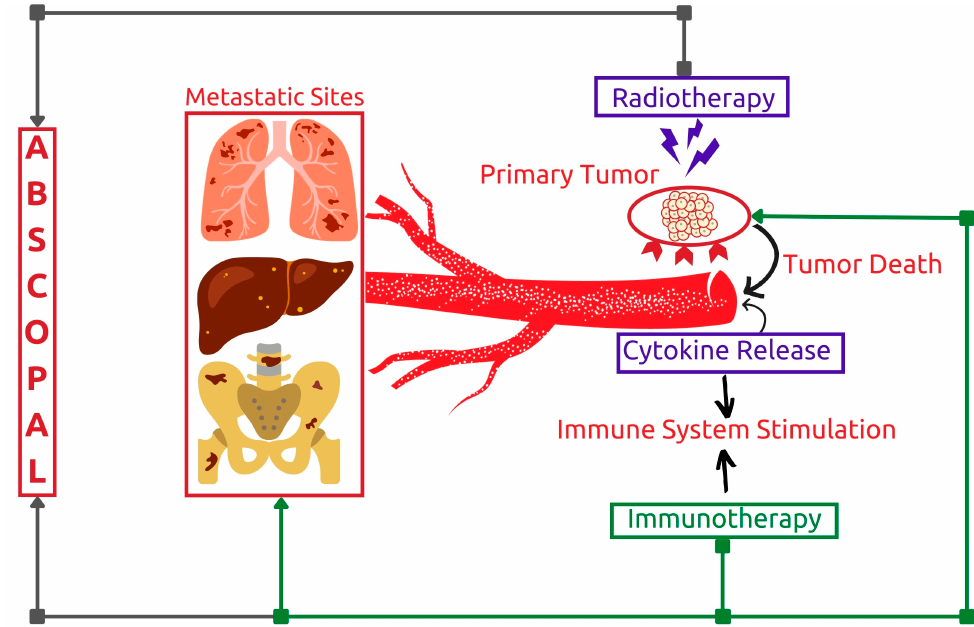
Figure 7. Graphical presentation of proposed abscopal effect mechanism.